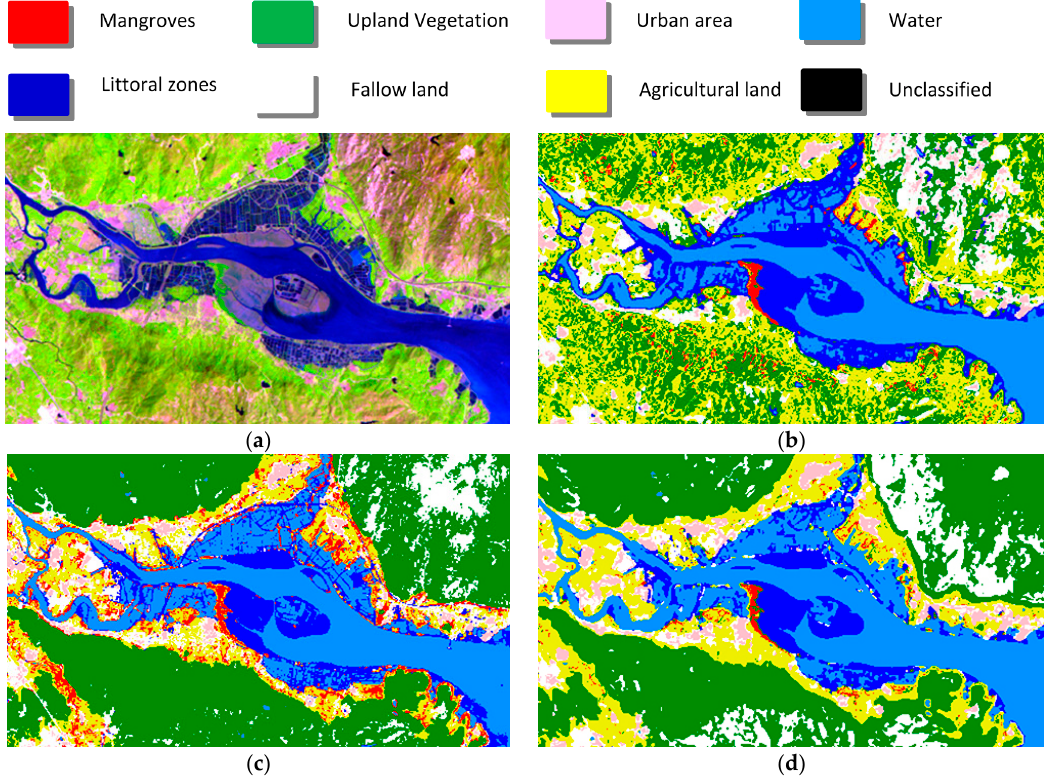
Figure 3. ( a ) TM Red Green Blue (RGB) (bands 5, 4, and 3) remote sensing image in the Zhangjiang estuary of Southeastern China on 25 September 2006. Classified images derived from ( b ) SRU, ( c ) MF-SVM, and ( d ) MF-SRU.